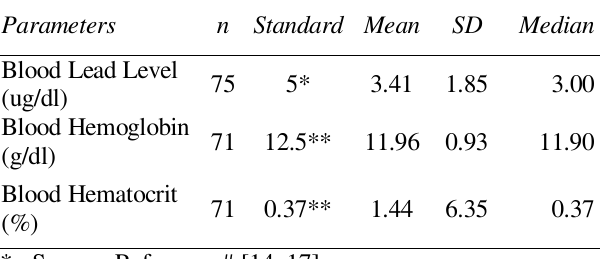
Table 3: Measures of Biological Outcomes